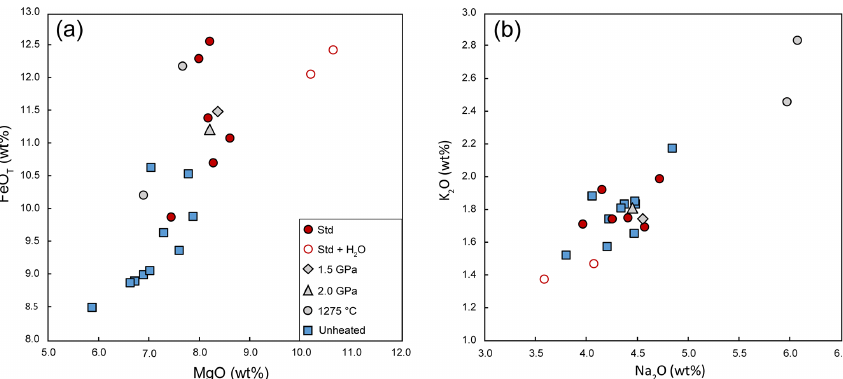
Figure 6. Major element compositions of unheated and homogenized melt inclusions. Symbols are as follows: solid blue squares, unheated melt inclusions; red circles, homogenization experiments at 2.5GPa–1300 ◦ C without water (solid red circles) or with added water (empty red circles); solid grey diamond, experiment at 1.5GPa–1300 ◦ C; solid grey triangle, experiment at 2GPa–1300 ◦ C; and solid grey circles, experiment at 2.5GPa–1275 ◦ C. All the compositions are corrected from PEC/PED and normalized to a total of 100% (on a volatile-free